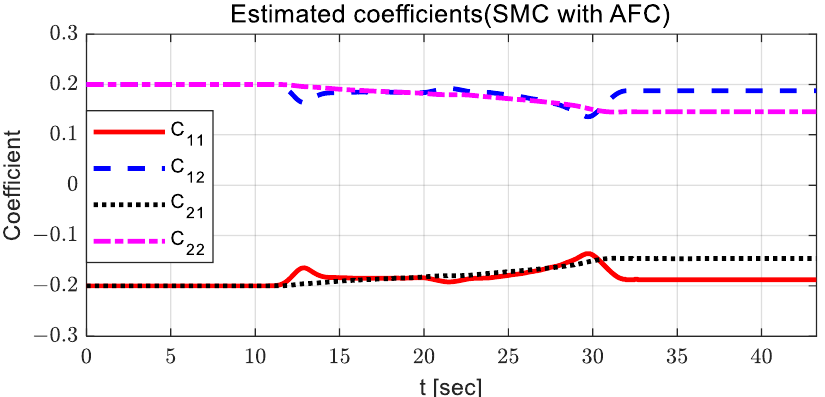
Figure 7. Results: estimated coefficients in the case of SMC with AFC for the curved path tracking.